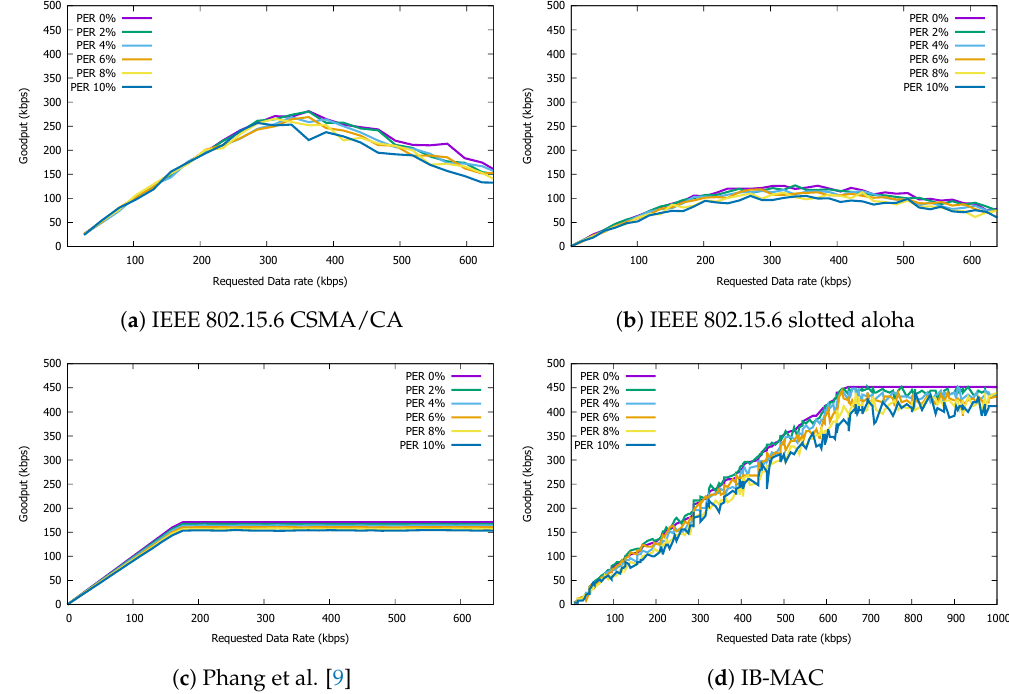
Figure 19. Goodput performance of IB-MAC and compared protocols under various packet error